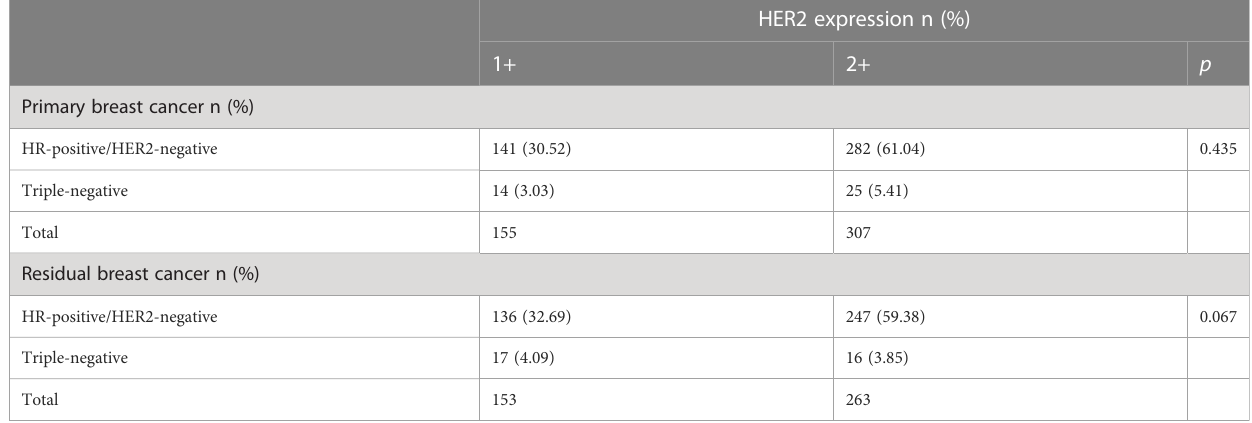
TABLE 3 Distribution of HER2 expression by IHC according to tumor phenotype in the HER2-low cohort.